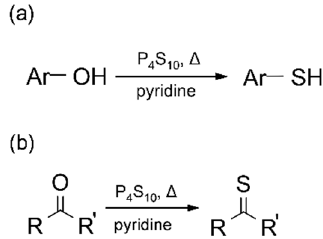
Figure 1. Schematic reaction of ( a ) alcohol and ( b ) ketone with Berzelius reagent in pyridine. Table 1. Relative atomic ratios and the amounts of functional groups in GO, mRGO, and tRGO prepared at different reaction temperatures.